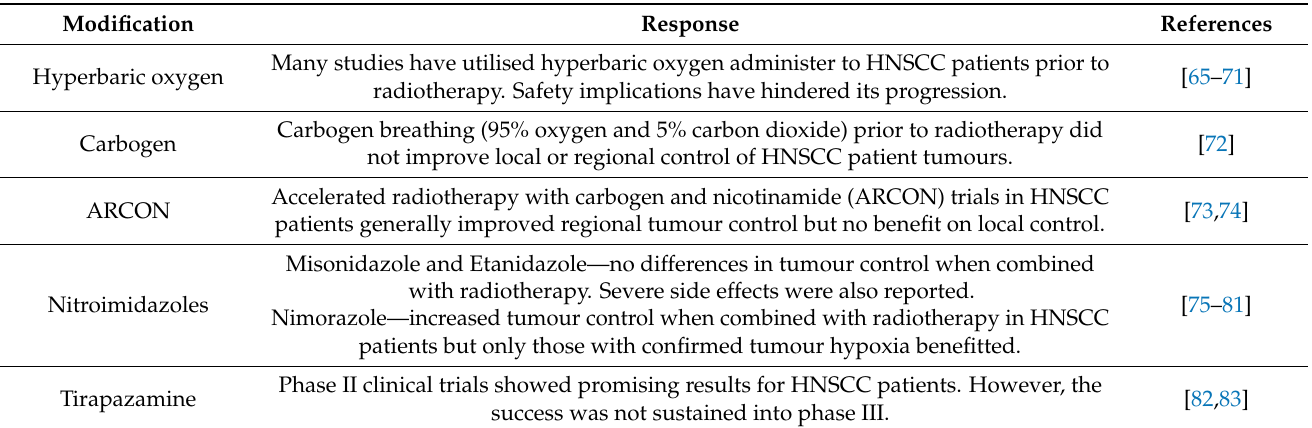
Table 1. Clinical trials performed to overcome hypoxic radioresistance in HNSCC.